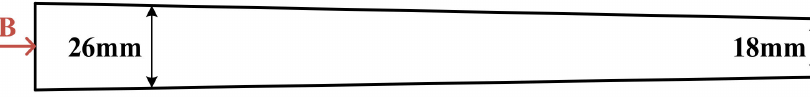
Figure 10. Structure of linear variable section stator ventilation